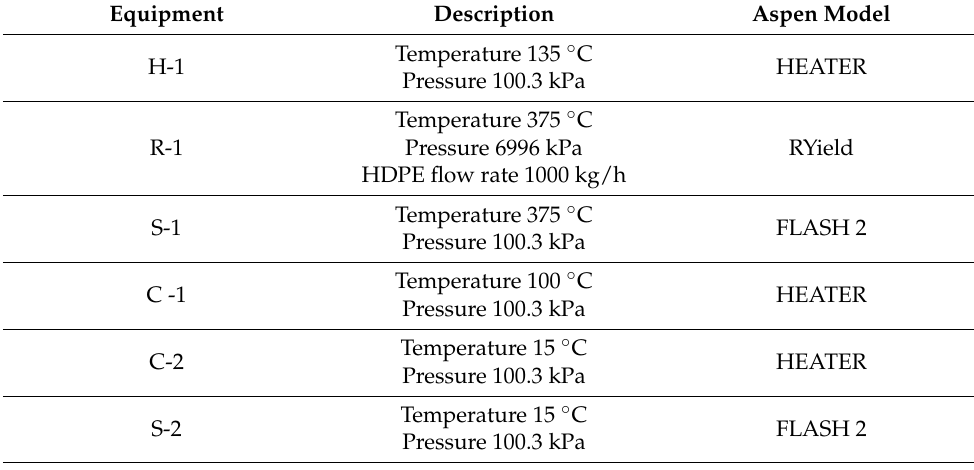
Thermodynamic package: